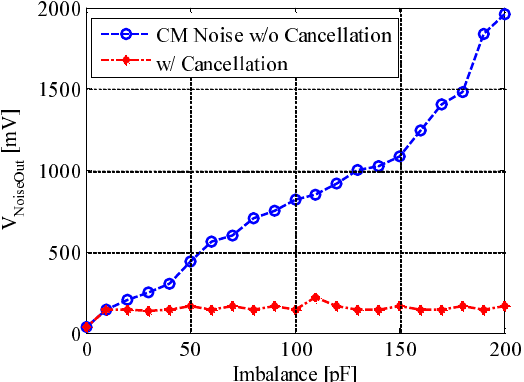
Figure 14. Noise reduction efficacy of our approach. The noise source is a 1 V, 60 Hz sine wave. The blue circled line is the CM noise output when the imbalance is forced in the capacitors emulating the EBIs; the red dotted line is the result when the imbalance is overcame by means of appropriate selection of ordinary capacitors